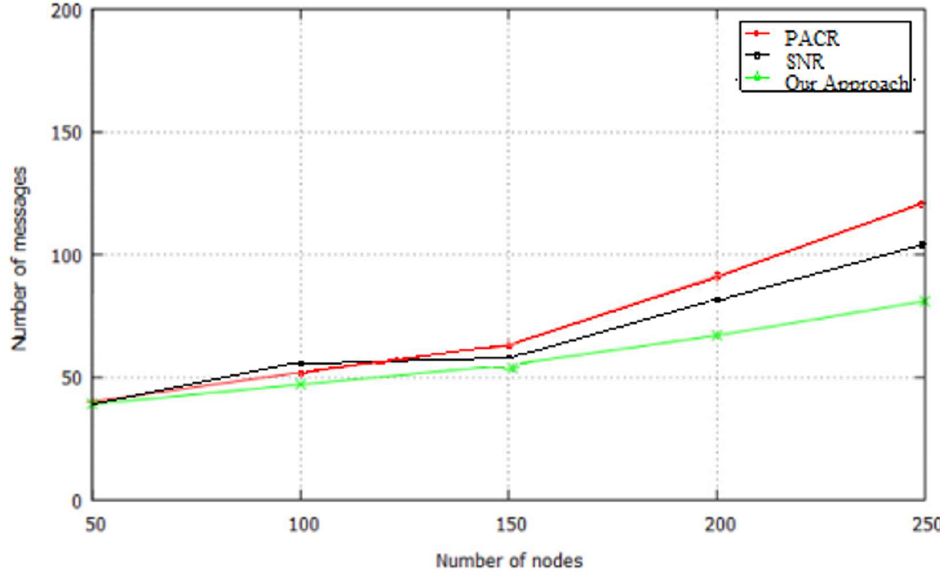
Figure 5. The number of nodes messages overhead.